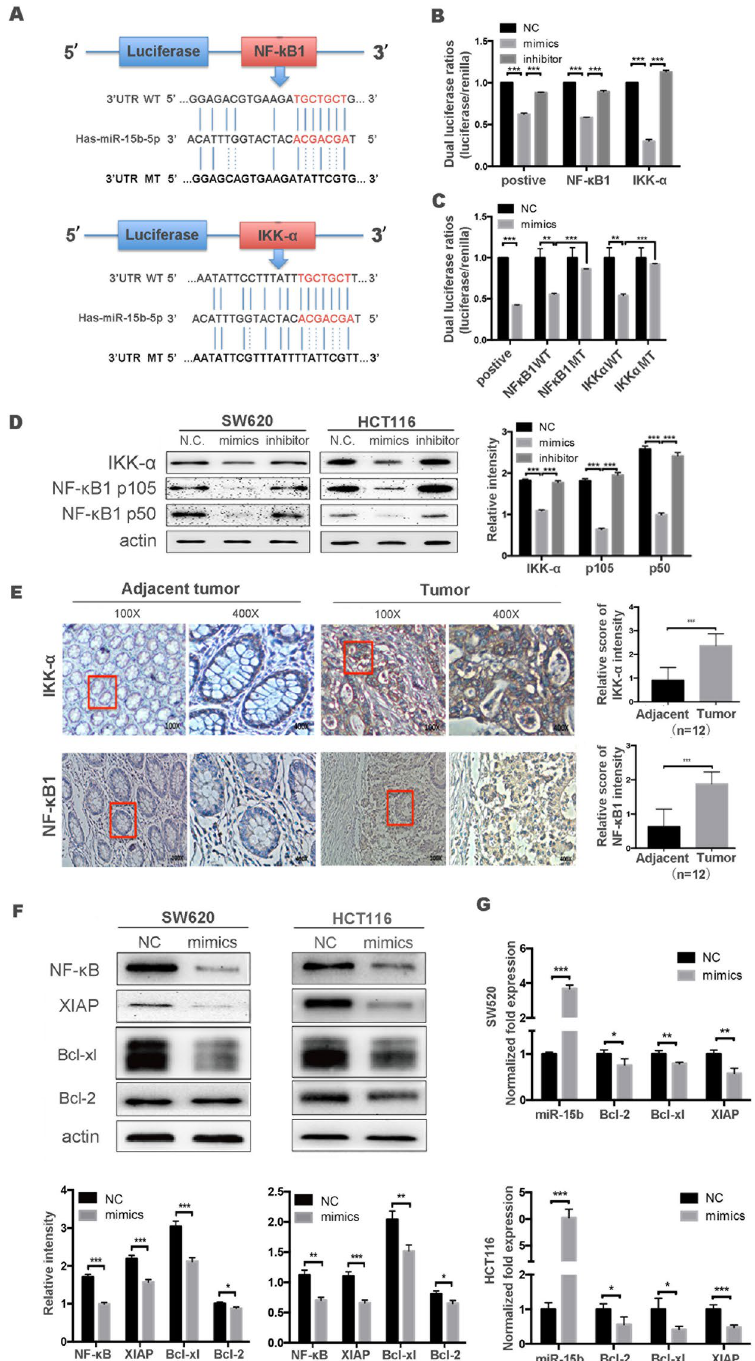
Figure 4. NF-ĸB1 and IKK- α are targets of miR-15b-5p in colon cancer cells. ( A ) Schematic representation of the miR-15b-5p putative binding sites in the 3-UTR of NF-ĸB1 or IKK- α mRNA and the mutations introduced into the 3-UTR regions. ( B ) Wild-type (WT) or mutated type (MT) NF-ĸB1 or IKK- α reporter constructs were co-transfected with miR-15b-5p mimics or NC in HEK293T cells. ( C ) miR-15b-5p mimic or inhibitor was co-transfected with the pMIR-NFĸB1-3 ′ UTR or pMIR-IKK α -3 ′ UTR vector in HEK293T cells. The relative luciferase activity was measured. ( D ) NF-ĸB1 and IKK- α protein expression after transfection of miR-15b-5p mimic or inhibitor in SW620 and HCT116 cells. Cells were evaluated at 48 h after transfection by western blotting. Semi-quantitative data from densitometric analysis were presented as the relative ratio of each protein to actin. ( E ) Representative images of the IHC staining of NF-ĸB1 or IKK- α in 12 colorectal cancer patients. ( G ) Western blot analysis of anti-apoptotic XIAP, Bcl-xl, and Bcl-2 protein levels in SW620 or HCT116 cells at 48 h after transfection with the miR-15b-5p mimic or a negative control. Actin was used as an internal control. ( F ) RT-qPCR analysis of relative mRNA expression level in cells at 24 h after transfection with the miR-15b-5p mimic or negative control ( * p < 0.05, ** p < 0.01, *** p <